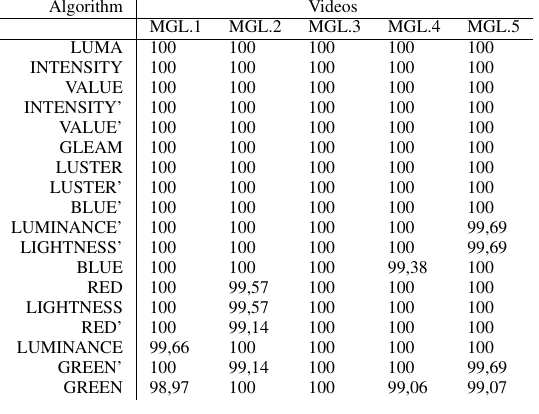
TABLE VI T EMPLATE 4: % OF FRAMES WITH ENOUGH GOOD MATCHING Algorithm